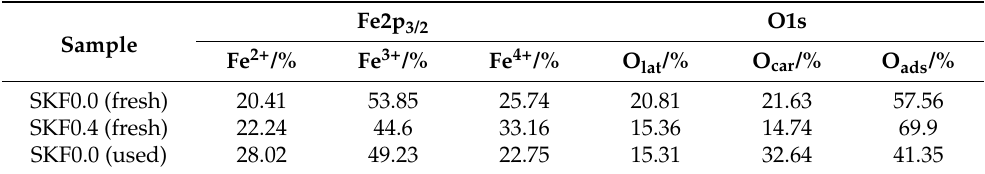
Figure 10. O 1s and Fe 2p XPS spectra and deconvolution of spend samples: ( a , c ) SKF0.0; ( b , d ) SKF0.4 (H 2 /CO 2 = 3/1, 350 °C, 1.0 MPa, GHSV = 7200 mL  gcat. − 1  h − 1 ). To conduct the regeneration of the perovskite structure, the oxidation behaviors of the SKFx (x = 0–0.6) catalysts after reaction were investigated using thermogravimetric analysis under an O 2 atmosphere. As shown in Figure 11, all the used SKFx (x = 0–0.6) catalysts underwent three stages: a mass-loss stage I at around 300 °C, followed by a mass- gain stage II, and then a sharp mass-loss stage III above 600 °C. Compared with the con- stant mass of the SrFeO 3 , stage I was attributed to the oxidation of FeC x . The maximum mass loss of SKF0.4 manifested the highest amount of FeC x forms in the catalytic process. The following mass-gain stage II resulted from the oxygen-obtaining process of the oxy- gen-deficient perovskite. This suggested the excellent regeneration of the used catalyst to its perovskite structure. It was surprising to observe the occurrence of O 2 release, even